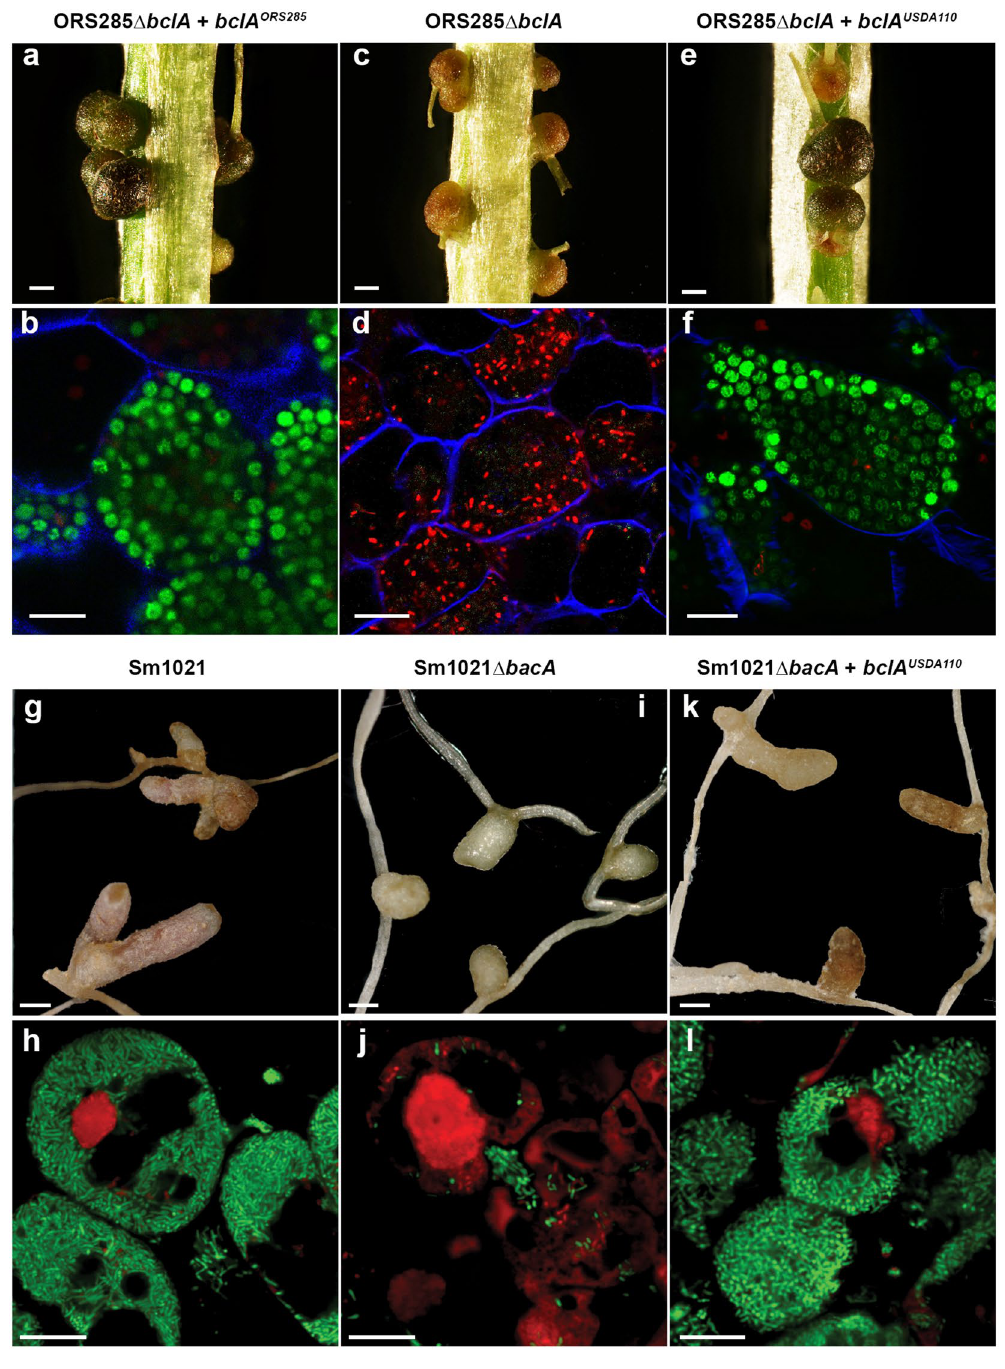
Figure 3. The bclA gene of B. diazoefficiens USDA110 complements the bclA mutation in Bradyrhizobium sp. ORS285 Δ bclA and the bacA mutation in S. meliloti Sm1021 Δ bacA . ( a , c , e ) Phenotype of A. indica nodules at 14 dpi, infected with the indicated strains. Scale bars are 1 mm. ( b , d , f ) Bacteroid viability determined by live/ dead and calcofluor white staining of nodule sections and confocal microscopy in A. indica nodules induced by the indicated strains. Scale bars are 10 µ m. ( g , i , k ) Phenotype of M. sativa nodules at 28 dpi, infected with the indicated strains. Scale bars are 1 mm. ( h , j , l ) Bacteroid viability determined by live/dead staining of nodule sections and confocal microscopy in M. sativa nodules induced by the indicated strains. Scale bars are 10 µ